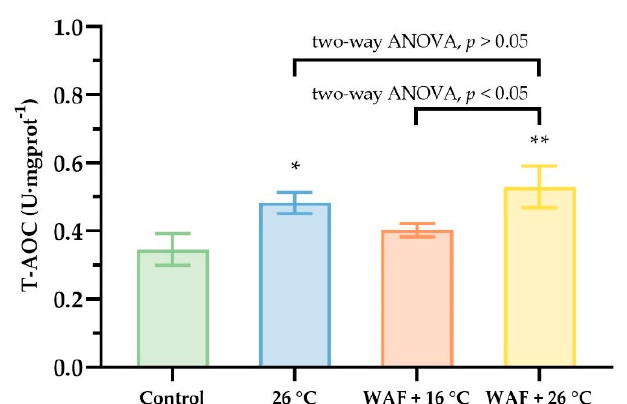
Figure 4. Total antioxidant capacity (T-AOC) in the body wall of sea cucumber following exposure to elevated temperature (26 ◦ C, light-blue filled), water-accommodated fractions (WAF) of Oman crude oil at an optimal temperature of 16 ◦ C (WAF + 16 ◦ C, light-red filled), and Oman crude oil WAF at an elevated temperature of 26 ◦ C (WAF + 26 ◦ C, light-yellow filled). The Control was the sea cucumber exposed to pre-filtered natural seawater only at an optimal temperature of 16 ◦ C (light-green filled). Asterisks (* or **) denote the significant differences between the treatments and the Control ( p < 0.05 or 0.01, respectively). Dark traits denote the significant differences among the treatments (two-way analysis of variance (ANOVA)).